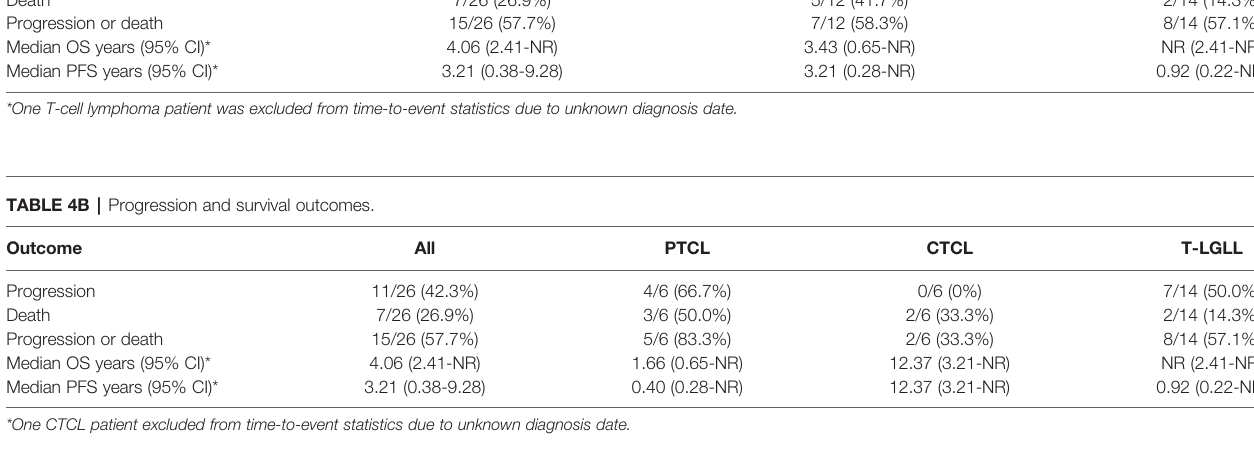
survival outcomes, see Tables 4A, B . The median OS for patients with T-LGLL was not reached ( Figure 2 ), while the median OS for patients with TCL was 3.4 years ( Supplementary Figure S1 ). When TCL is broken down by disease, the median OS for PTCL was 1.7 years, and the median OS for CTCL was 12.4 years. In total, 42.3% of patients had progression of their T-cell malignancy. Six of the 12 (50%) patients with T-LGLL and 4/6 (67%) of patients with PTCL had refractory disease, while 0% with CTCL had progression (on frontline treatment). Median overall PFS was 3.21 years. For patients with T-LGLL, the median leukemia-free survival was 11 months ( Figure 2 ), and for patients with TCL, the median